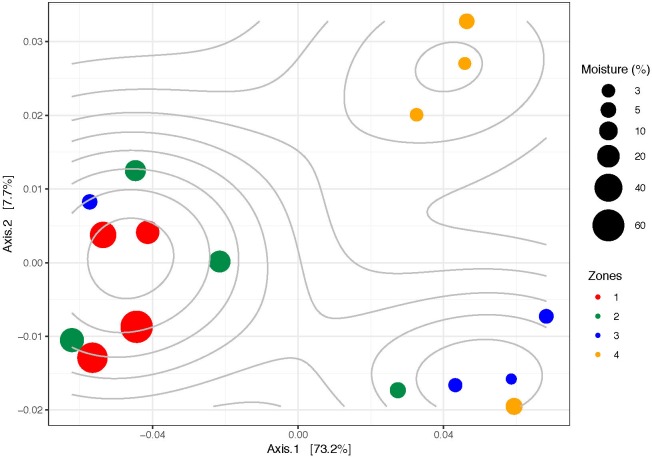
Community similarities visualized via principal coordinate analysis (PCoA) with weighted UniFrac distances. The size of each circle indicates the soil moisture (%). Contour lines were generated by 2D kernel density estimation and highlight the clustering of communities.